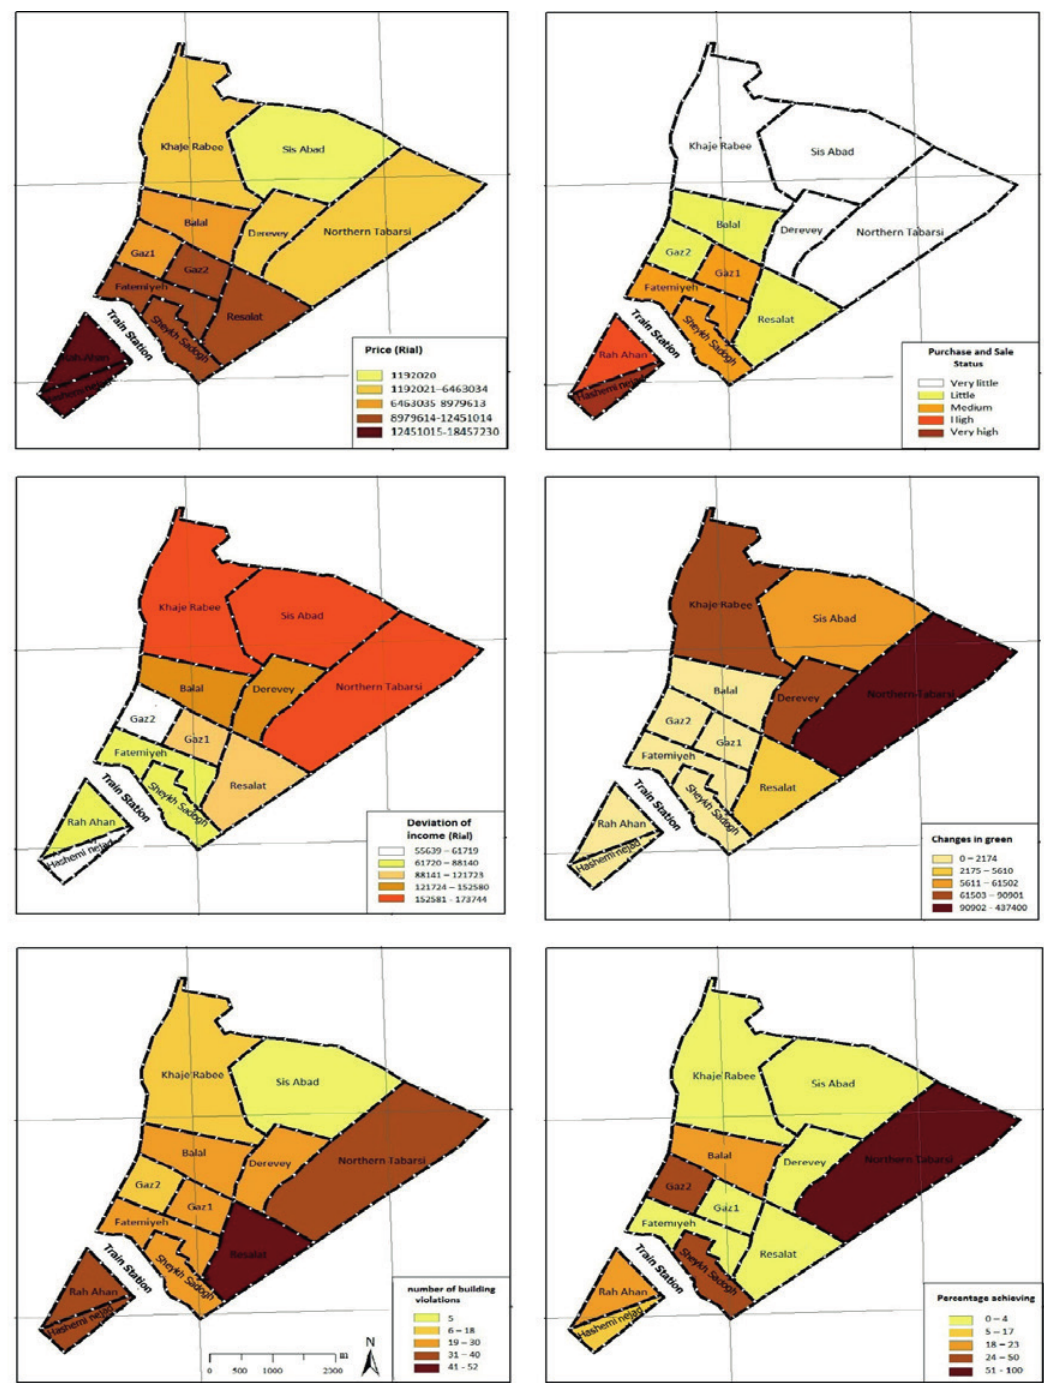
Fig. 3. Land price and urban land market indicator in third district of